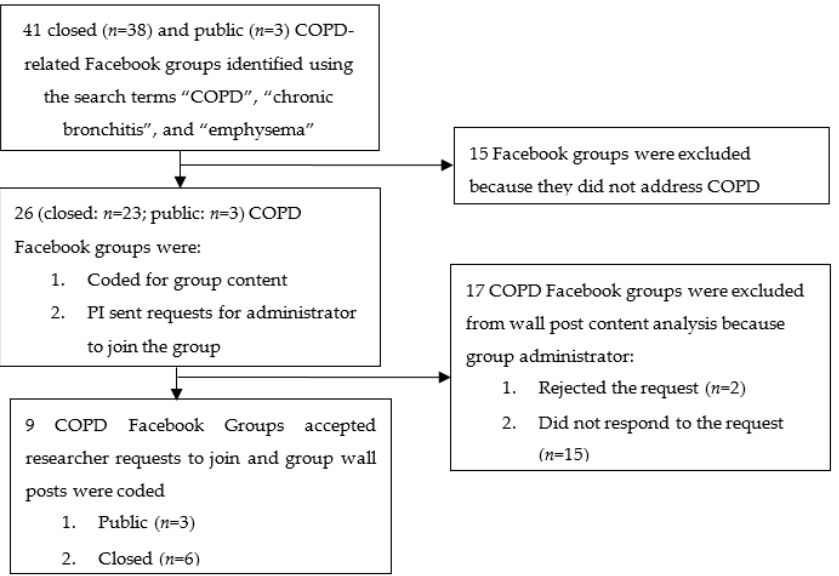
Figure 1. Flowchart depicting Chronic Obstructive Pulmonary Disease (COPD) Facebook group selection process.